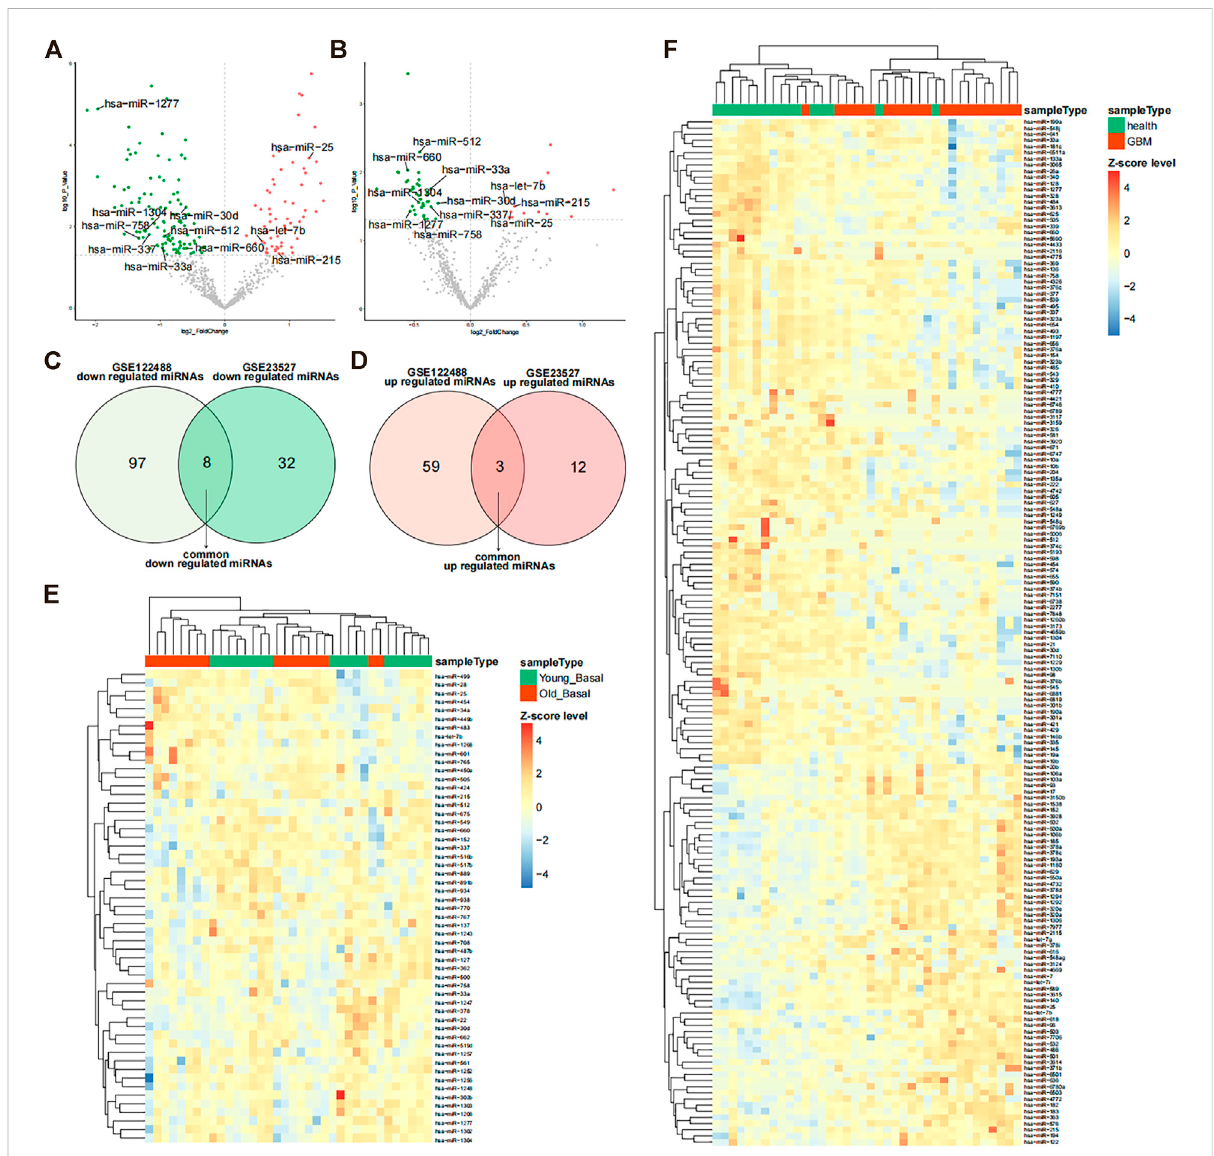
FIGURE 1 Differentially expressed miRNAs in glioma and muscle. (A) Volcano plot of differentially expressed miRNAs in the GSE122488 dataset. Green dots indicate downregulated miRNAs and red dots indicate upregulated differential miRNAs. Common differential miRNAs of both datasets are marked on the plot. (B) Volcano plot of differentially expressed miRNAs in the GSE23527 dataset (glioma vs. healthy). Green dots indicate downregulated miRNAs and red dots indicate upregulated differential miRNAs. Common differential miRNAs of both datasets are marked on the plot. (C,D) Venn diagram of differential downregulated and upregulated miRNAs in the two datasets. (E) Expression heatmap of differentially expressed miRNAs in the GSE23527 dataset. MiRNA expression values were Z-score transformed. (F) Expression heatmap of differentially expressed miRNAs in the GSE122488 dataset; miRNA expression values were transformed by the